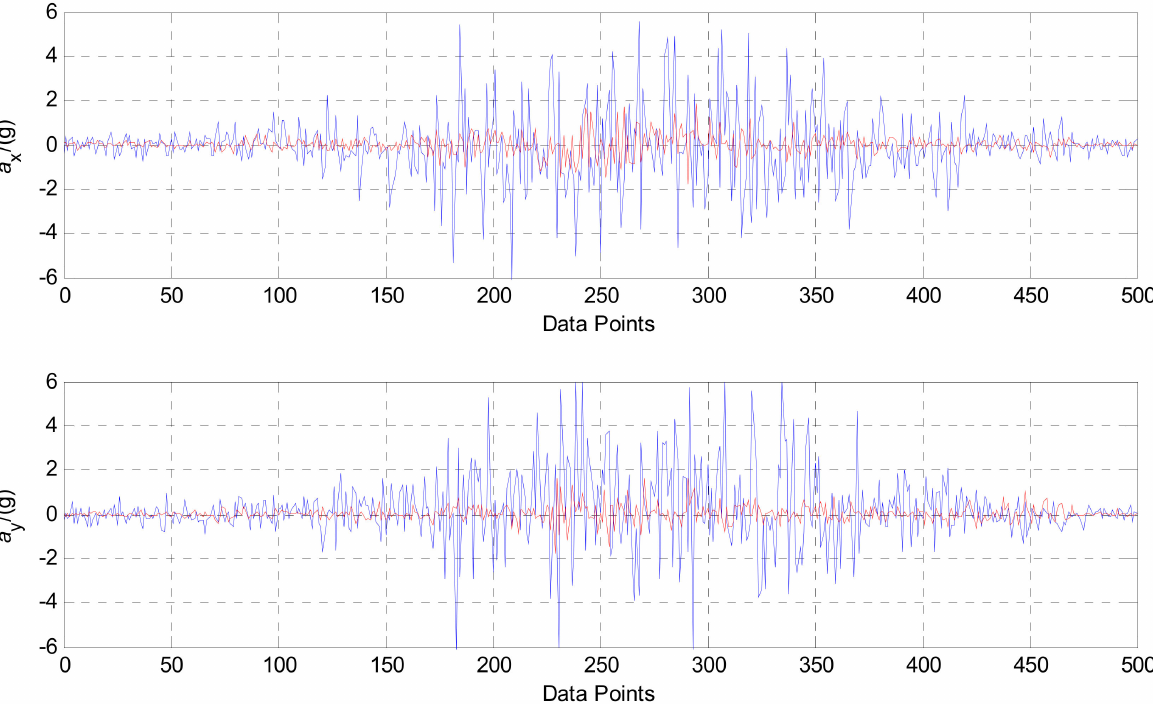
Figure 11. The estimation results of the field-drilling signal of the x and y-axis accelerometer sensor by SR and CPT based on the Duffing